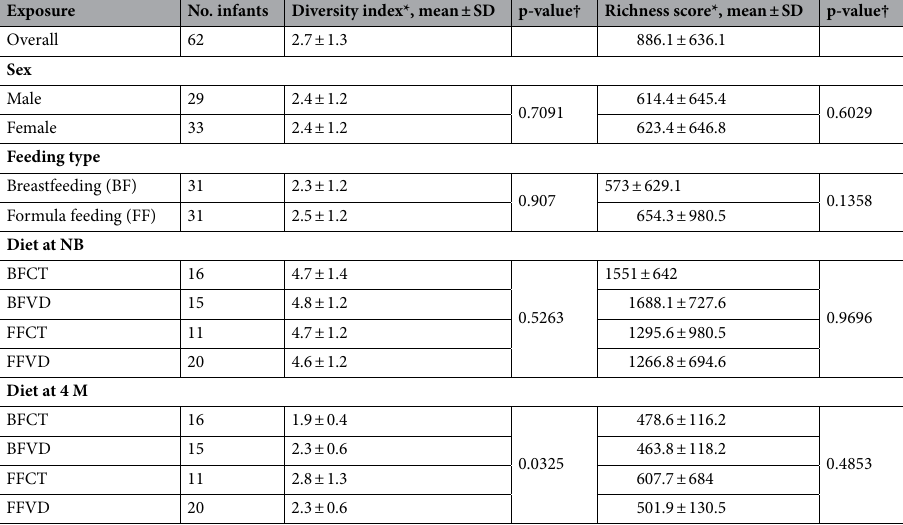
lus (3.3% vs. 1.0%) also have higher abundance in BFVD versus BFCT group. In contrast, the genus Bacteroides was observed with lower abundances in the BFVD group instead of pure breastfed infants without vitamin D supplementation (7.9% vs. 15.4%). The Shannon’s diversity indexes for the BFVD and BFCT samples on each time point (during the period from